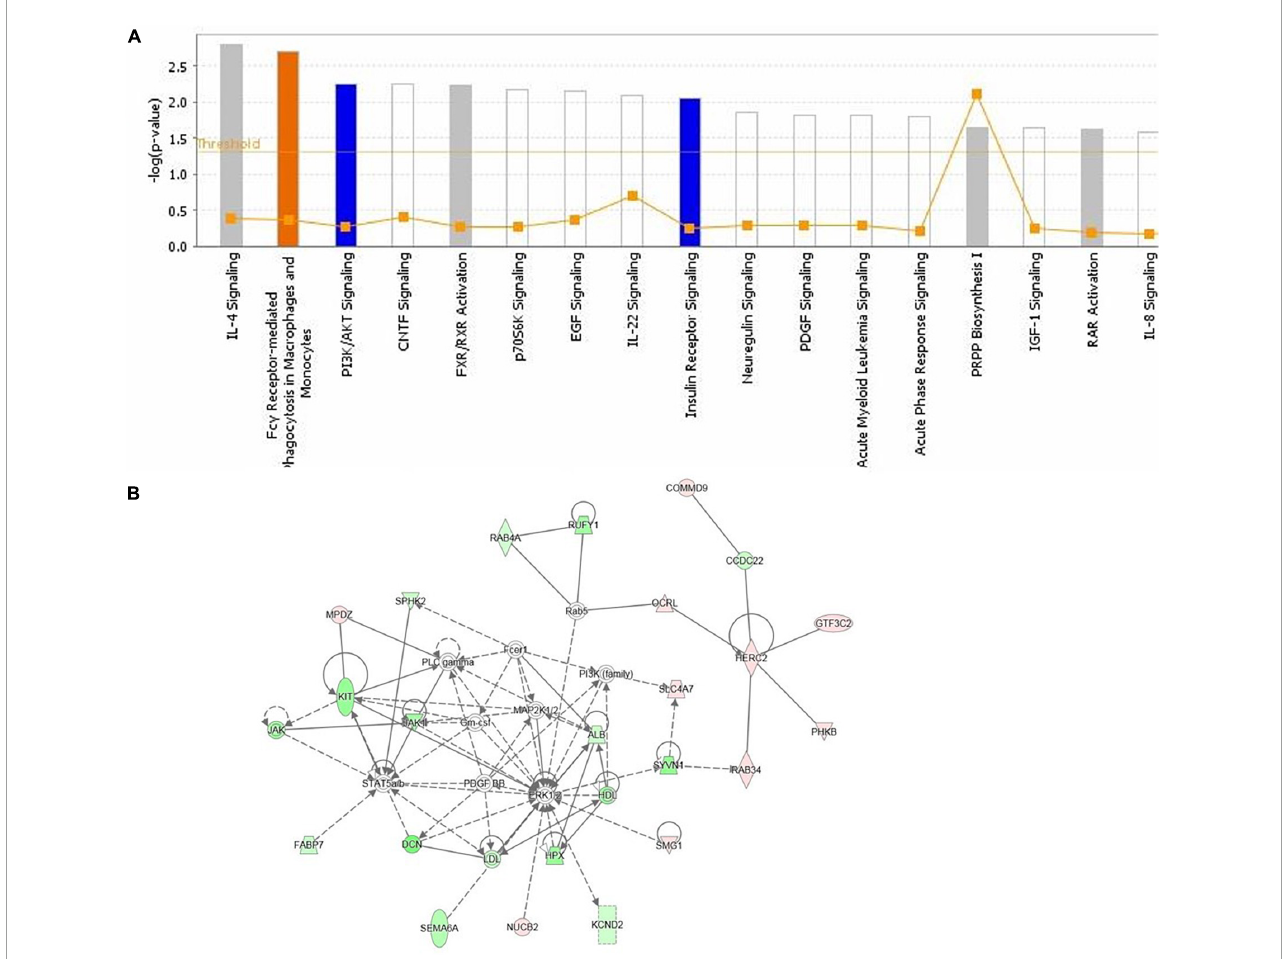
FIGURE5 (A) The highest ranked canonical IPA pathways of the differentially expressed proteins. The horizontal axis shows the pathway name and the vertical axis is the p -value of each pathway. (B) The top protein-protein interaction network responding to ASE treatment for PD was predicted by IPA. Twenty-six proteins are involved in this network. The symbols labeled in red and green represent up-regulation and down-regulation, respectively.